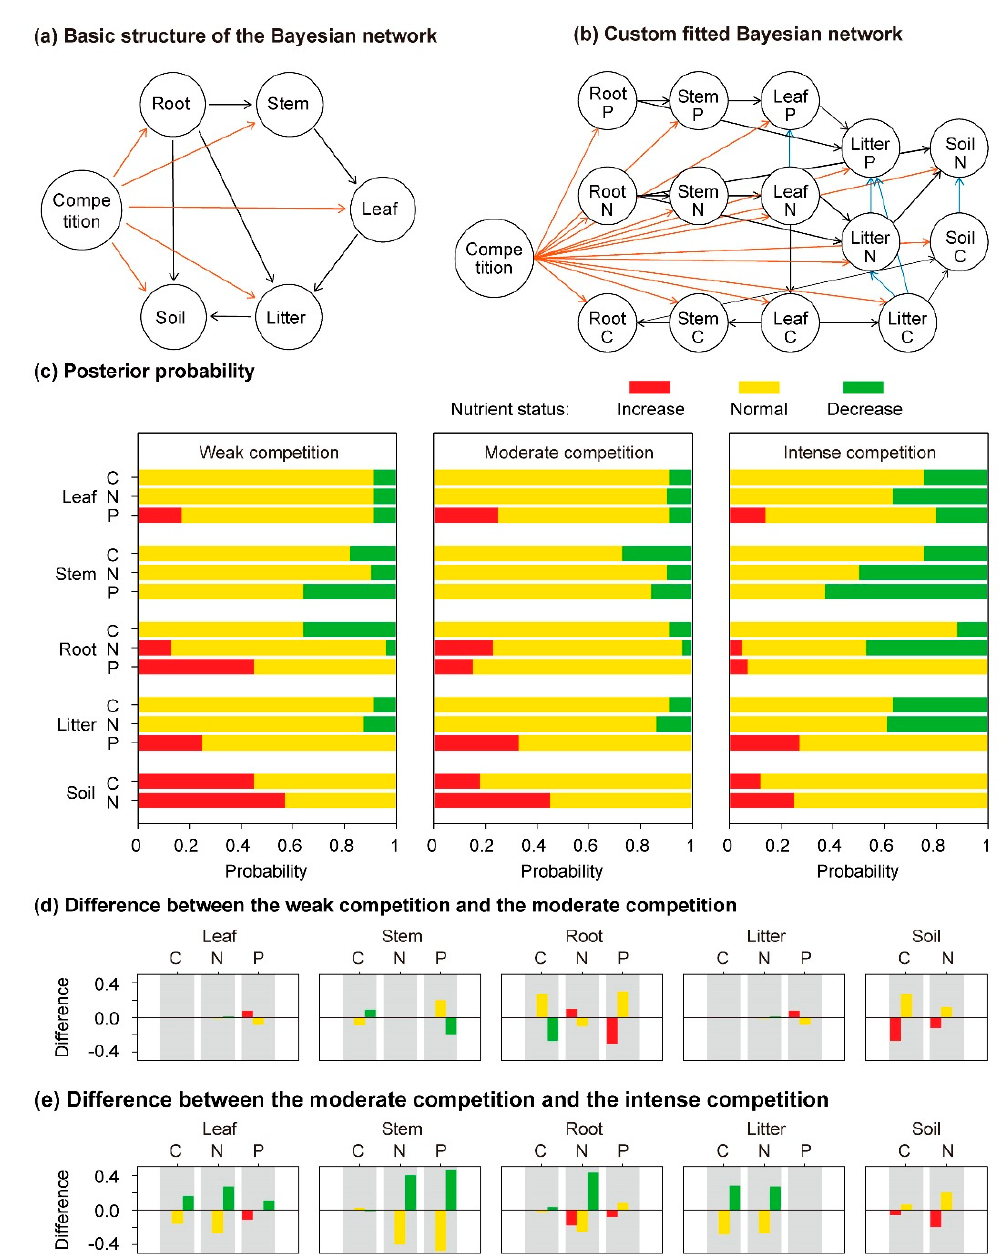
Figure 5. ( a ) The basic structure of the Bayesian network; ( b ) the custom fitted Bayesian network based on nutrient data and expert knowledge; ( c ) the posterior probability distributions of the variations in the nutrient status of the plant organs, litter, and soil under di ff erent competition intensities; the di ff erence in the probability of nutrient status between ( d ) the weak competition and moderate competition and between ( e ) the moderate competition and intense competition.